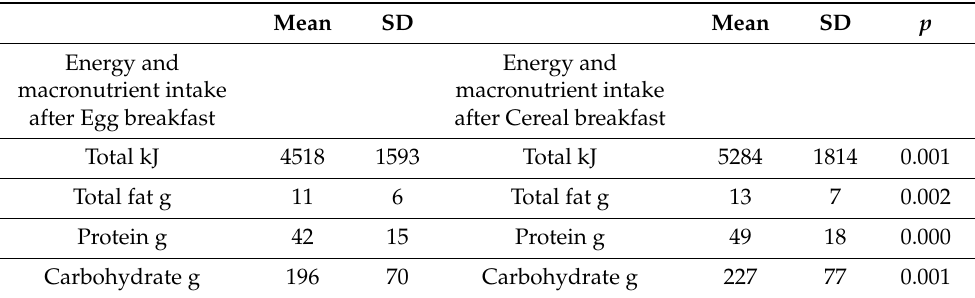
Table 2. Energy and macronutrient intake at